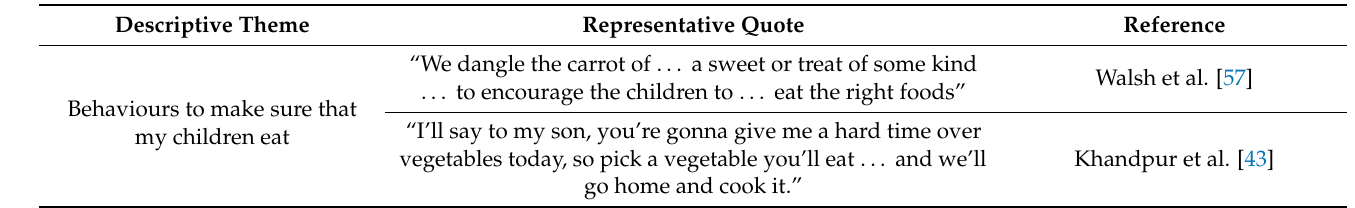
Table 6. Representative quotes for third analytical theme: observable behaviours of fathers during